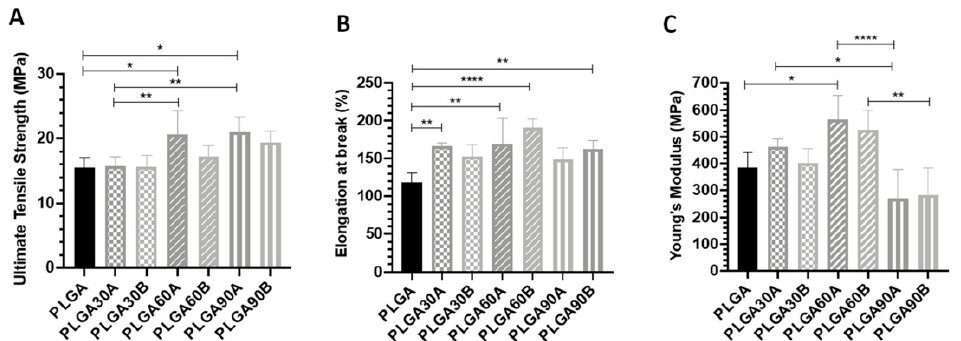
Figure 4. Mechanical properties ( A ) Ultimate Tensile Strength, ( B ) Elongation at break, and ( C ) Young’s Modulus of the untreated and CAP treated PLGA microfibers. *, ** and *** Statistically significant between the groups ( p < 0.05, p < 0.01, and p < 0.001,